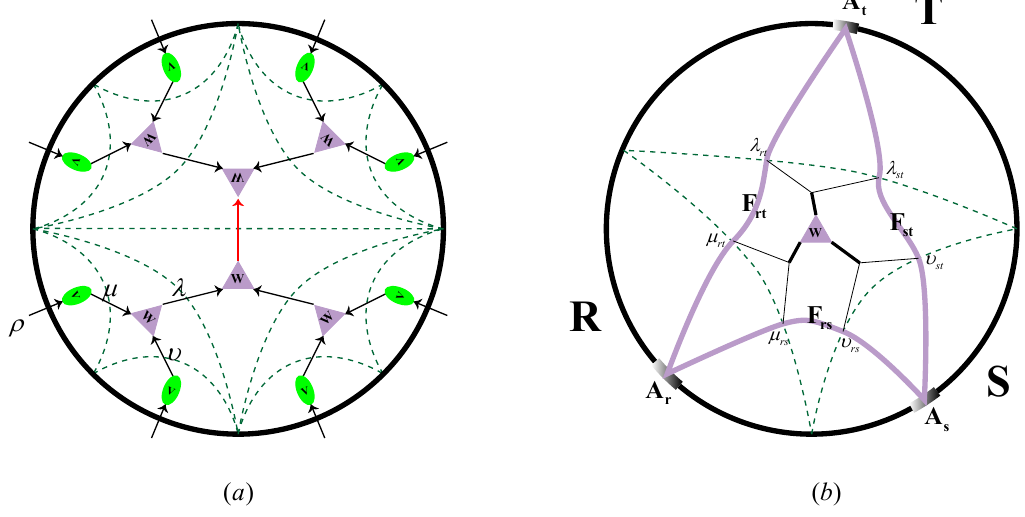
Figure 8 . (a) To match our locking qubit thread model with a holographic tensor network model, using thread /state correspondence, two types of tensor V and W are constructed. V represents the distillation tensor, while W plays the role of a disentangler . An inward-pointing arrow corresponds to a lower index, while an outward-pointing arrow corresponds to an upper index. (b) The thread/state prescription of the explicit expression for a general W